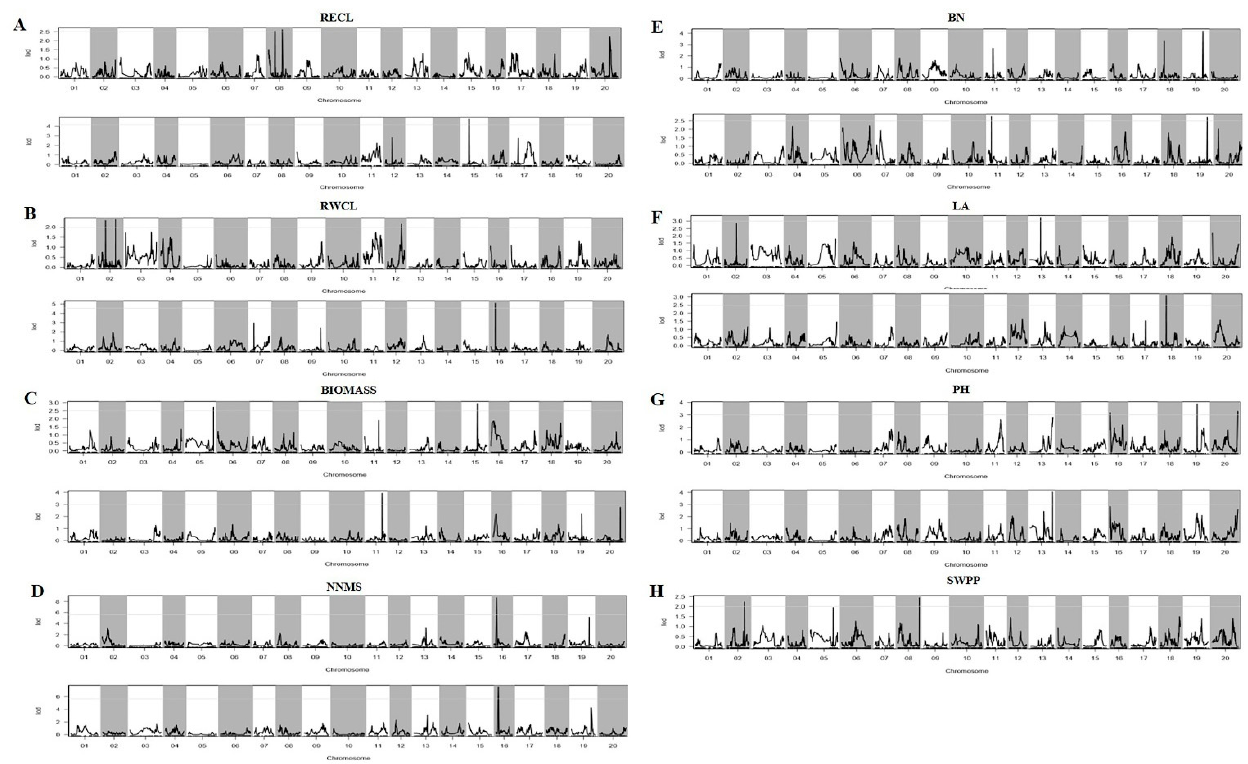
Figure 5. ( A ) RECL map positions (Mb) under well-watered condition and RECL map positions (Mb) under drought stress. ( B ) RWCL map positions (Mb) under well-watered condition and RWCL map positions (Mb) under drought stress. ( C ) BIOMASS map positions (Mb) under well-watered condition and BIOMASS map positions (Mb) under drought stress. ( D ) NNMS map positions (Mb) under well-watered condition and NNMS map positions (Mb) under drought stress. ( E ) BN map positions (Mb) under well-watered condition and BN map positions (Mb) under drought stress. ( F ) LA map positions (Mb) under well-watered condition and LA map positions (Mb) under drought stress. ( G ) PH map positions (Mb) under well-watered condition and PH map positions (Mb) under drought stress. ( H ) SWPP map positions (Mb) under drought stress. Table 2. Location and description of QTLs in RILs population derived from Jindou21 × Zhongdou33 grown under well-watered control (C) and drought stress (D) conditions.